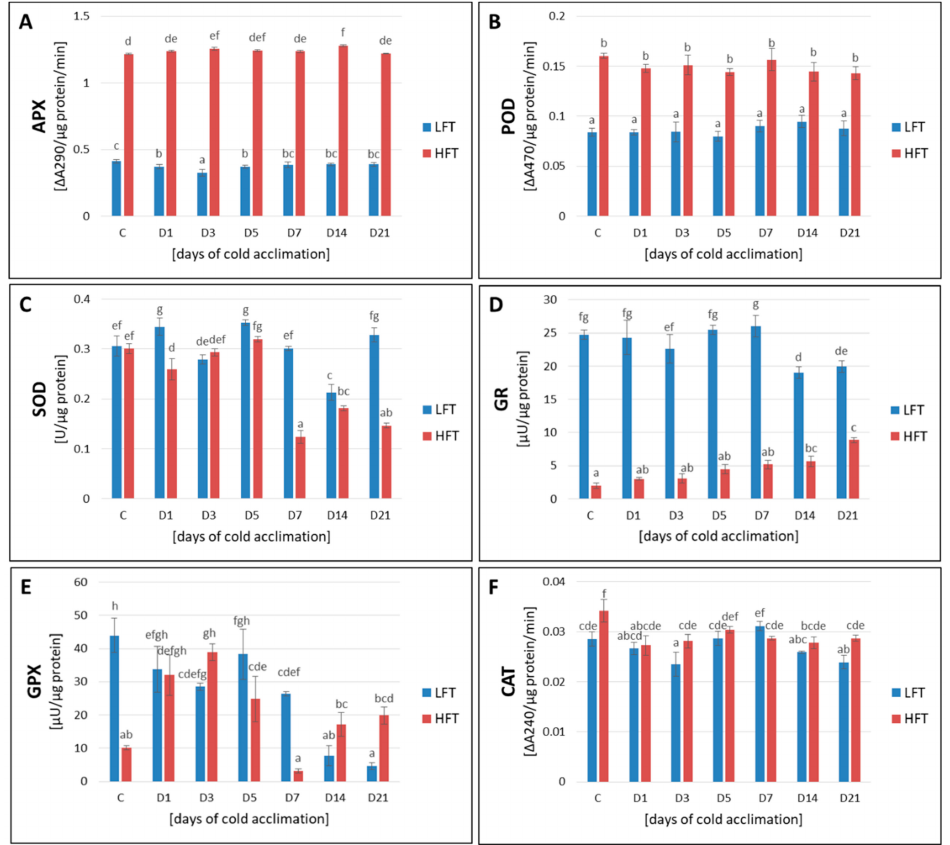
Figure 7. Total activity of ascorbate peroxidase (APX) ( A ), guaiacol peroxidase (POD) ( B ), superoxide dismutase (SOD) ( C ), glutathione reductase (GR) ( D ), glutathione peroxidase (GPX) ( E ), and catalase (CAT) ( F ), at seven time-points: before cold acclimation (CA) C and on the 1st, 3rd, 5th, 7th, 14th, and 21st day of CA in Lolium multiflorum / Festuca arundinacea introgression forms. Error bars represent the standard errors of four replicates for APX, CAT, and SOD; three replicates for GPX and GR; and six replicates for POD. Homogeneity groups are denoted by the same letters, according to Fisher’s LSD test ( p = 0.05). HFT–high freezing tolerant introgression form, LFT–low freezing tolerant introgression